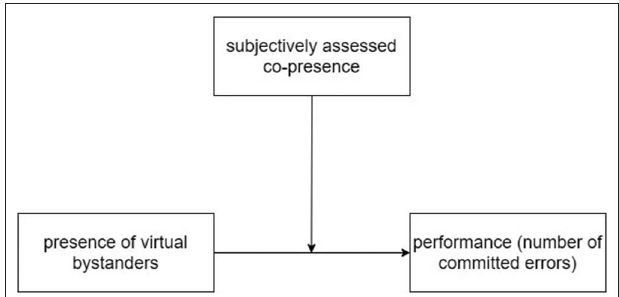
FIGURE 4 | Graphical representation of the moderation analysis (Hayes, 2013). Other tested moderators (sense of presence and perceived realism) could be put in place of co-presence in this